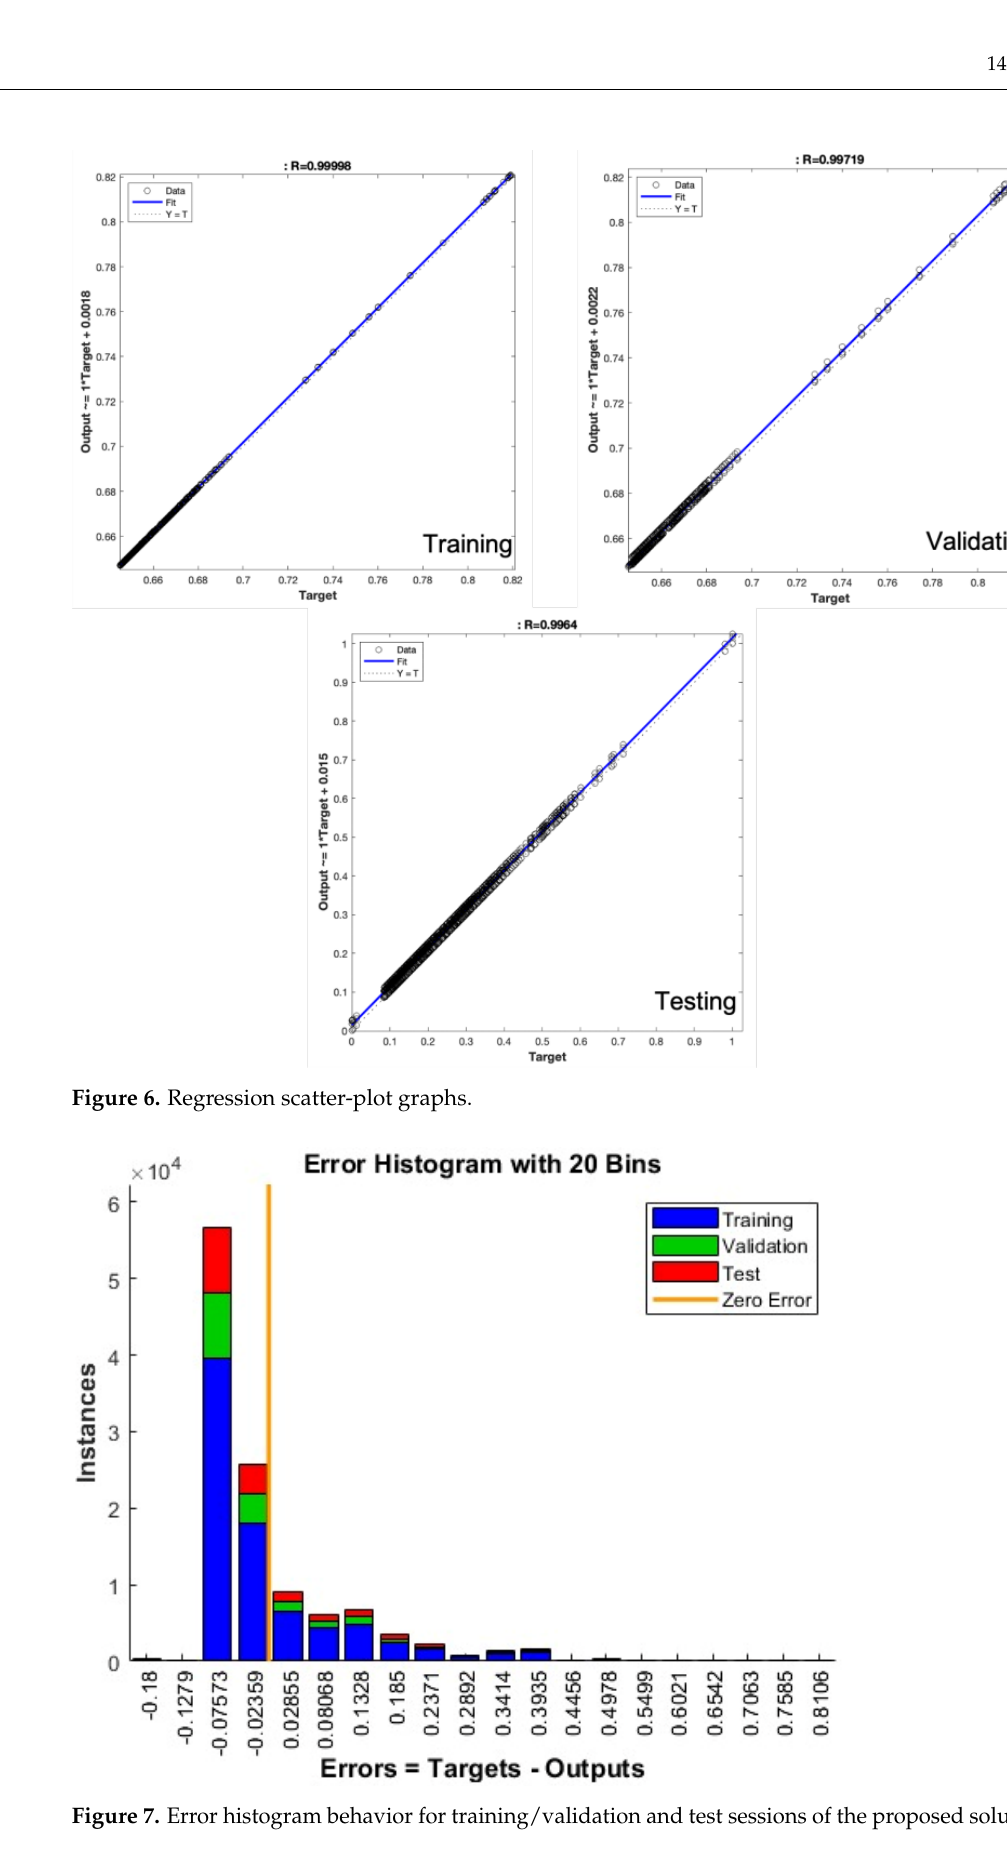
Figure 7. Error histogram behavior for training/validation and test sessions of the proposed solu- tion.